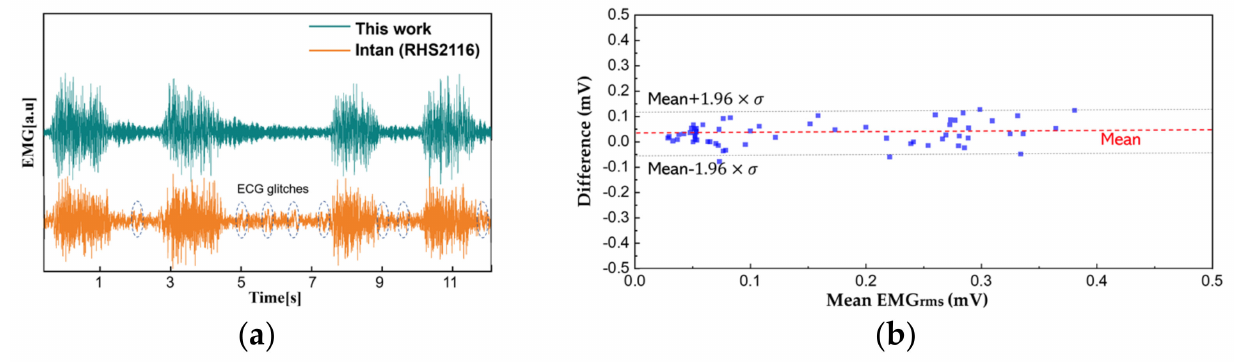
Figure 13. A comparison between this work and reference instrument. ( a ) Time domain EMG signals acquired from the right medial gastrocnemius muscle; ( b ) the Bland–Altman plot from EMG RMS